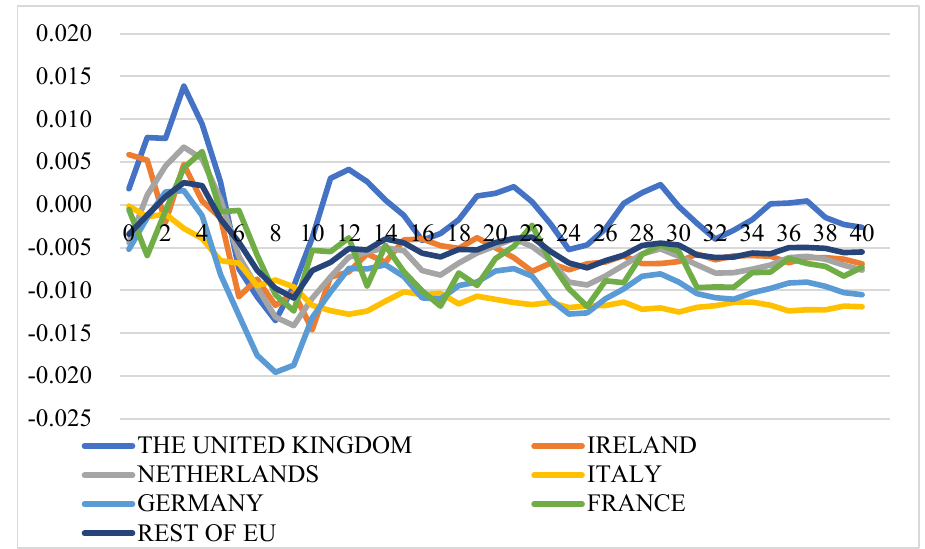
Figure 7. Generalized impulse response functions (GIRFs) of six EU member states’ intra-EU cheese export prices after a positive one-standard-error shock to crude oil price (bootstrap median estimates).